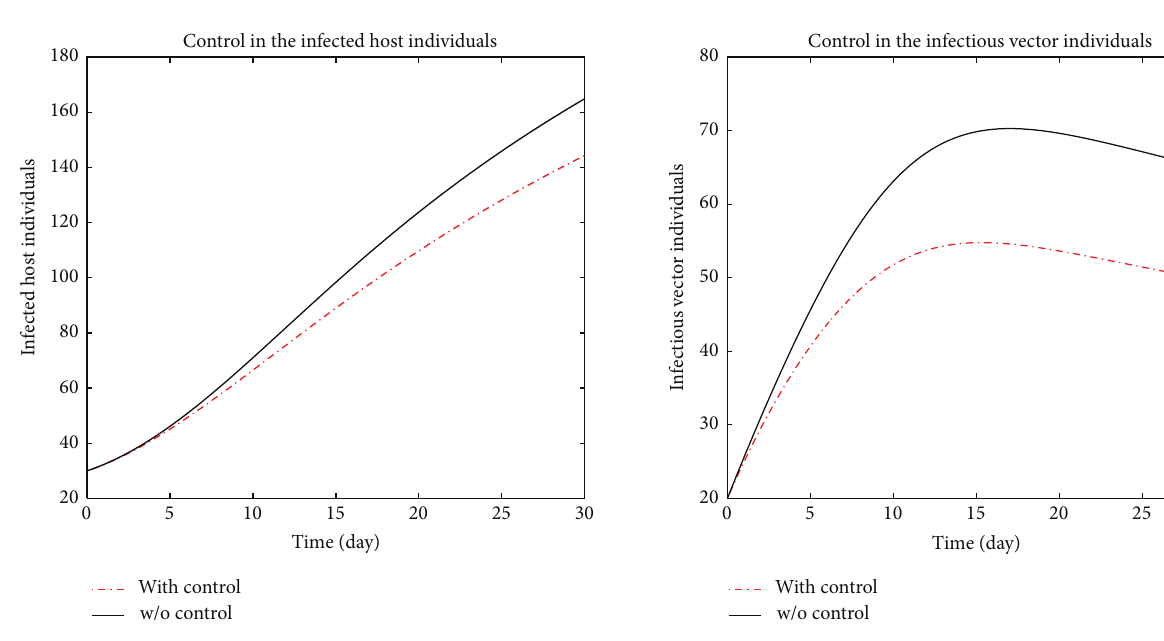
Figure 6: Plot of the number of infected hosts with and without control, 𝑢 1 = 0 , 𝑢 2 ̸= 0 .